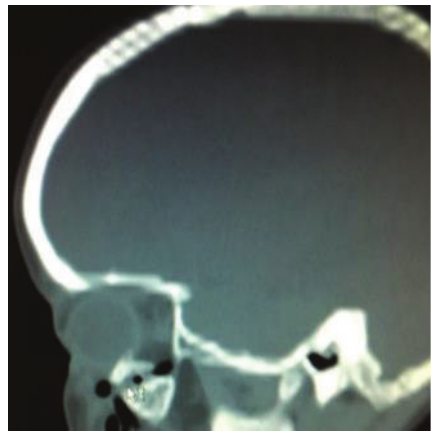
Figure 2: Sagittal Slice showing impingement of floor into posterior globe.